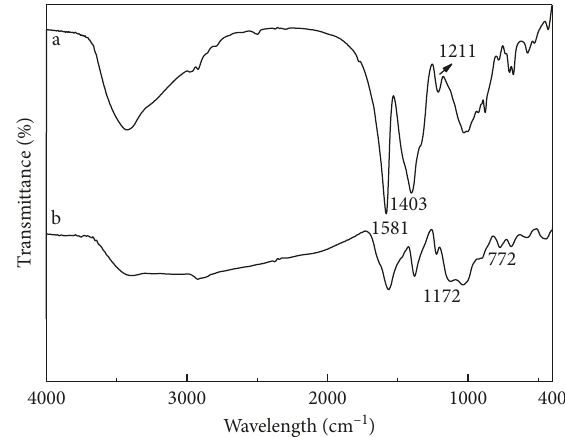
Figure 4: FT-IR spectra of amino-functionalized TGA-capped CdTe-QDs (a) and CdTe-QDs@MIPs (b).